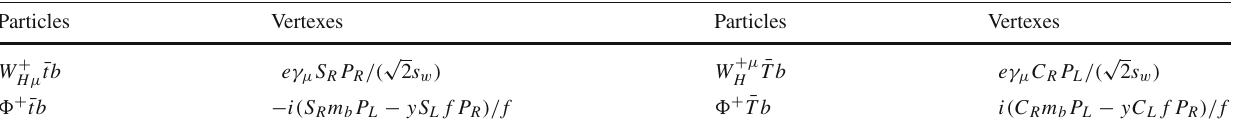
Table 1 The three-point couplings of the charged gauge boson–fermion–fermion and those of the scalar–fermion–fermion in the LRTH models. The chirality projection operators are P R , L = ( 1 ± γ 5 )/ 2 Particles Vertexes Particles